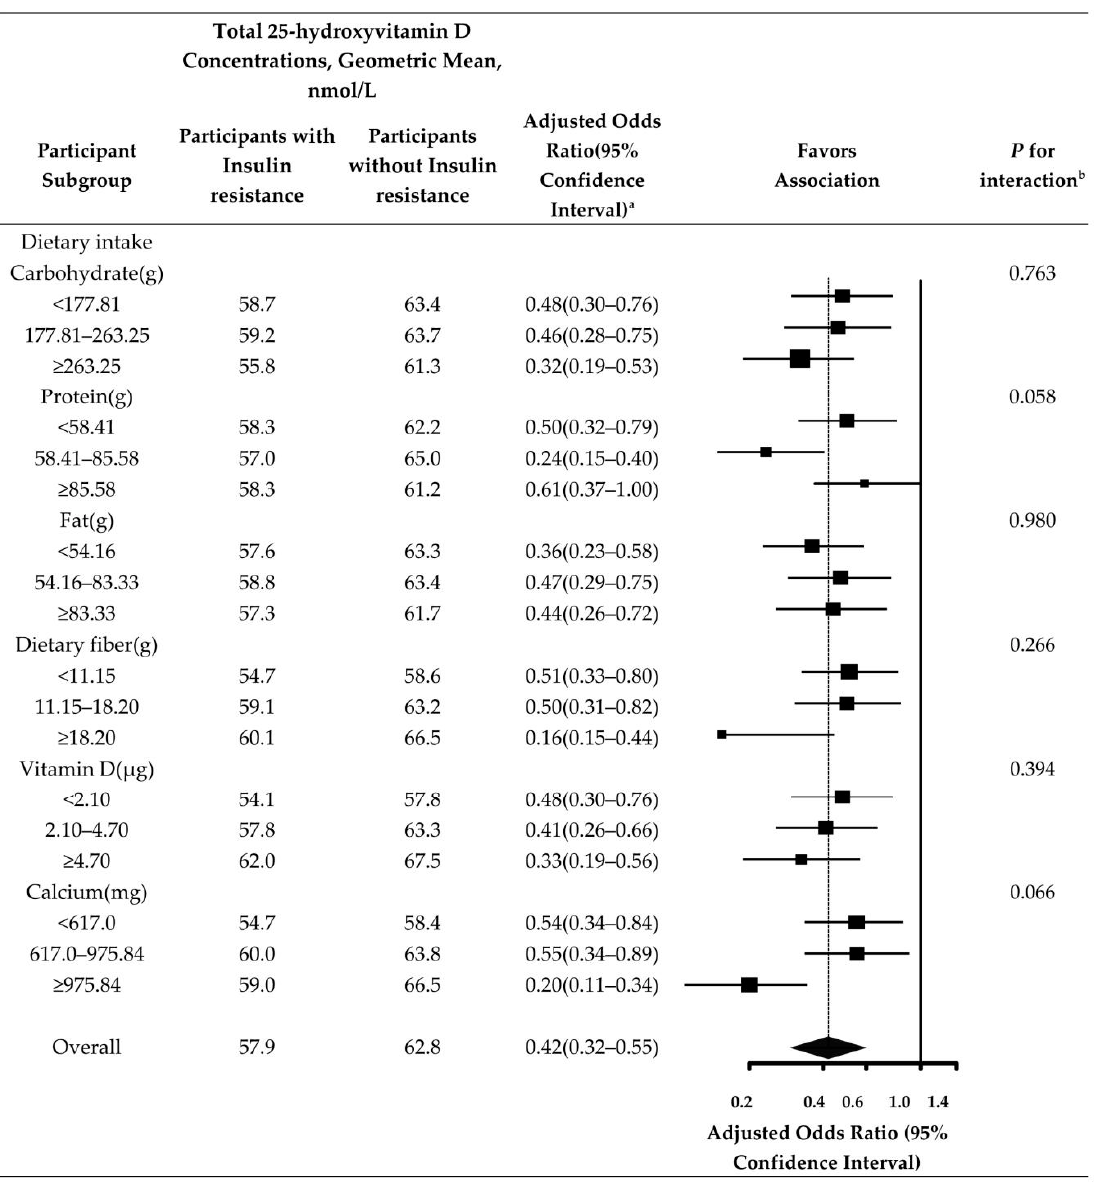
Figure 2. Total 25-hydroxyvitamin D Concentrations Comparing Participants With insulin resistance. a Odds Ratio (95% confidence interval) is also adjusted for creatinine (urine), albumin (urine), and cholesterol. b P for interaction based on log-transformed total 25-hydroxyvitamin D concentrations.